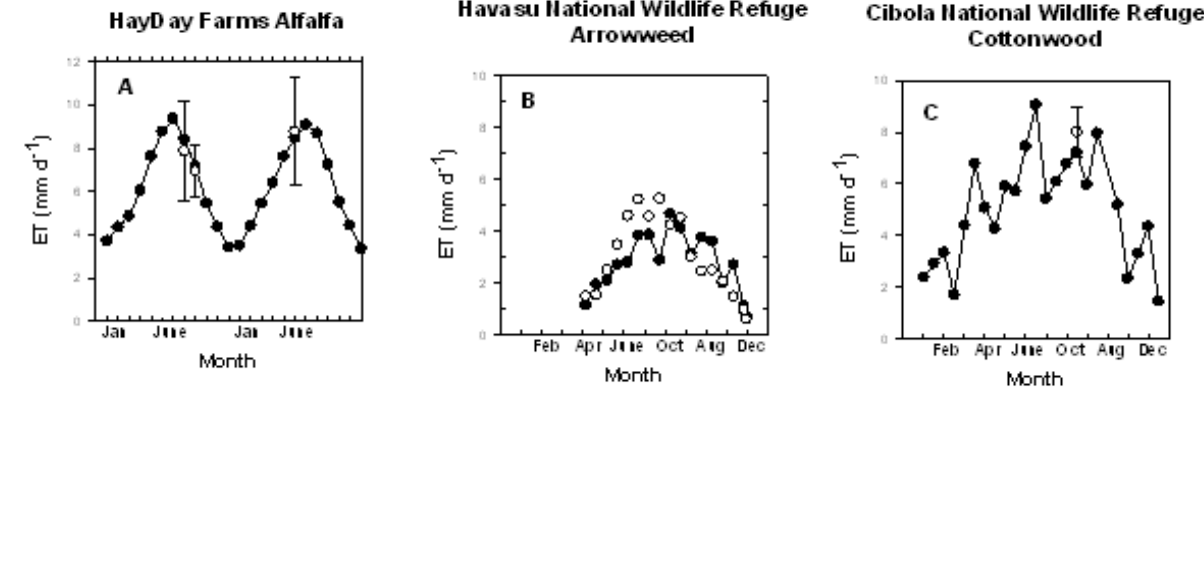
Figure 2. MODIS estimates (closed circles) of alfalfa (A); cottonwood (B); and arrowweed (C) ET plotted against ground estimates (open circles). Alfalfa was measured in 2006 and 2007 [15]; arrowweed was measured in 2003 [18]; and cottonwood was measured in 2005